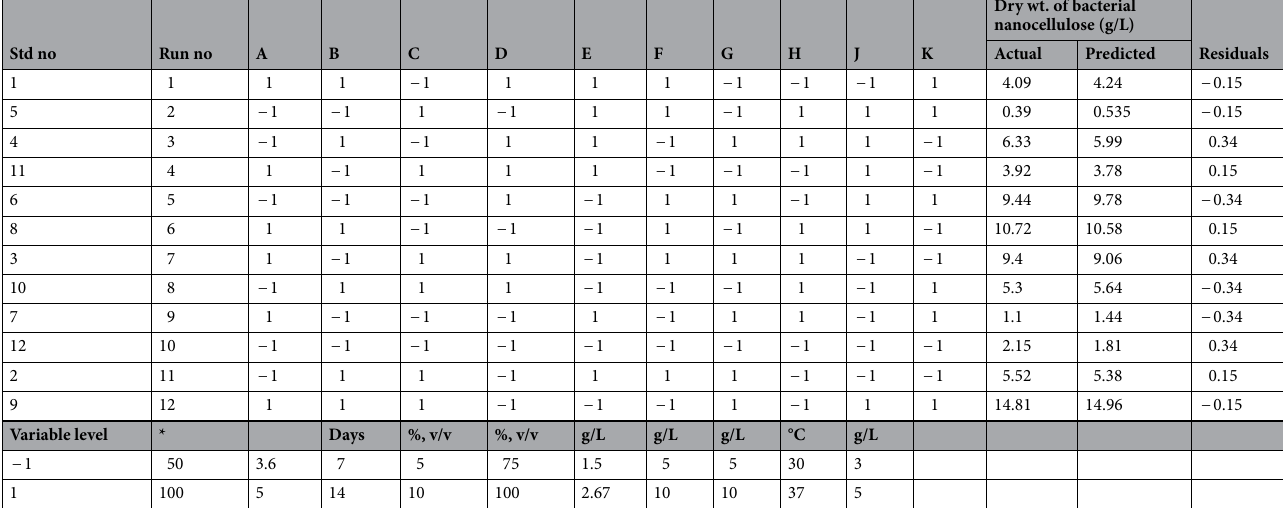
Table 2. Plackett–Burman experimental design for evaluation of independent factors for the production of bacterial nanocellulose by Bacillus sp . strain SEE-3 with coded values along with the experimental bacterial nanocellulose. The independent factors are: A * (medium volume; mL/250 mL conical flask), B (pH), C (incubation time; days), D (inoculum size; %, v/v), E (Cantaloupe juice; %, v/v), F (citric acid; g/L); G (peptone; g/L), H (yeast extract; g/L), J (temperature; °C), K (Na 2 HPO 4 ;